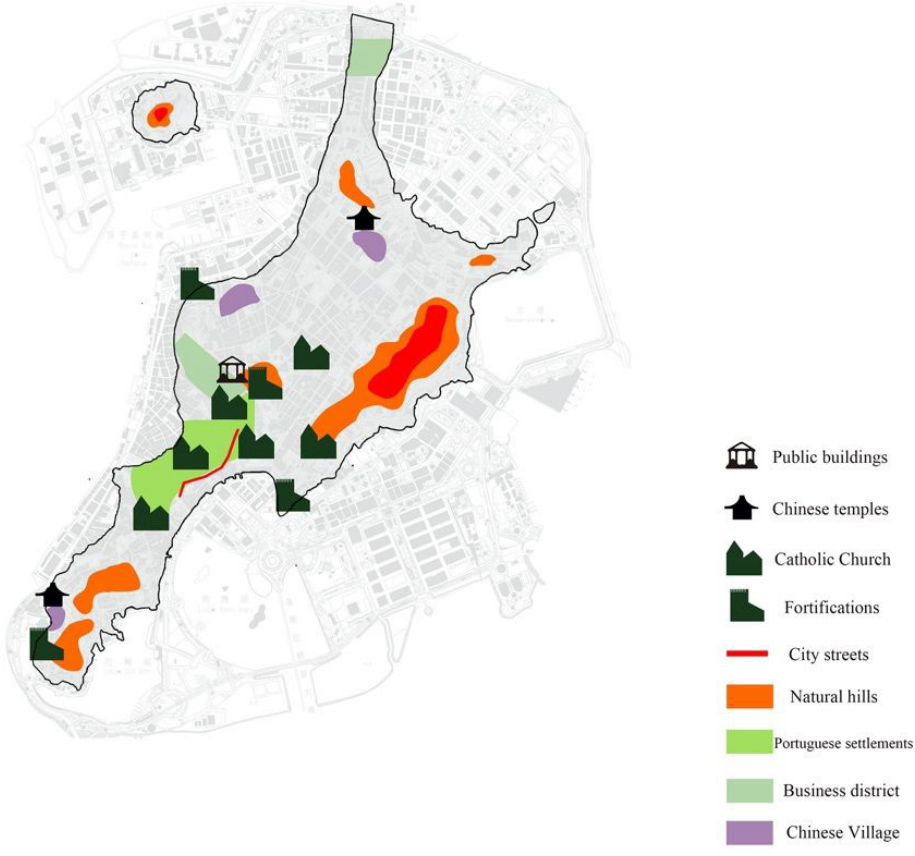
Fig. 1 Main buildings of Macau in the 16th